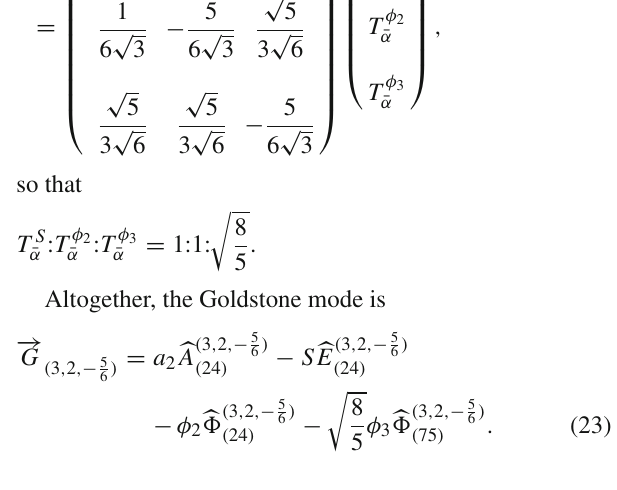
6 Goldstone modes for SSB of G 51 : [(3, 2, 1